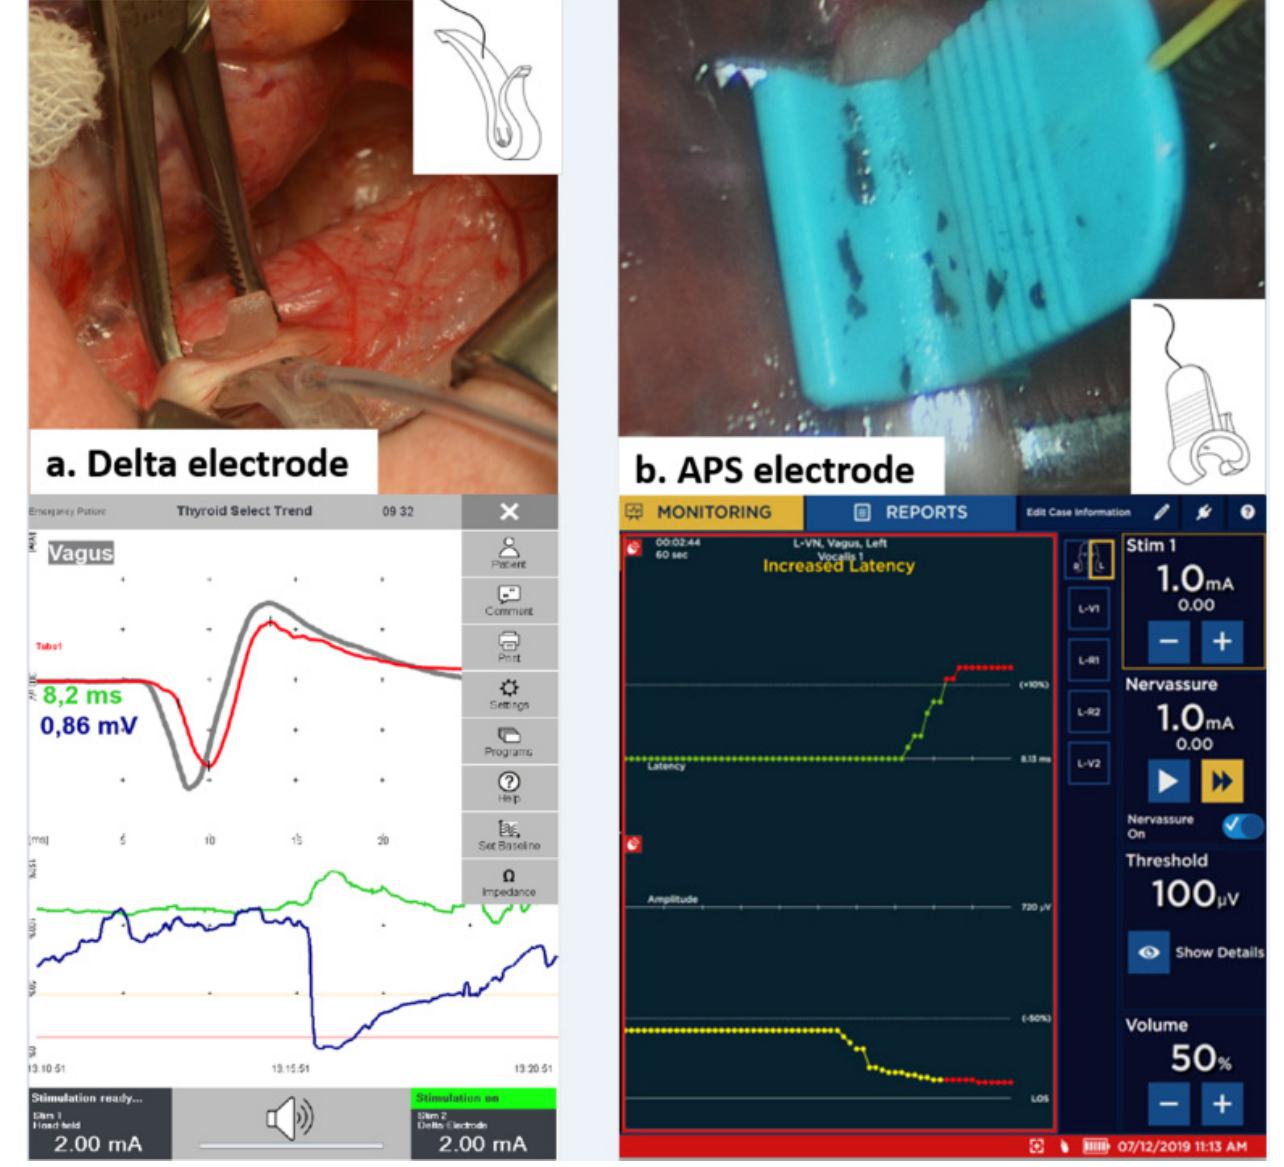
Figure 1. Representation of different C ‐ IONM electrodes (geometry and position of probe on the VN): ( a ) Delta and ( b ) APS, with their relative EMG profiles obtained below. In both cases, a 360°